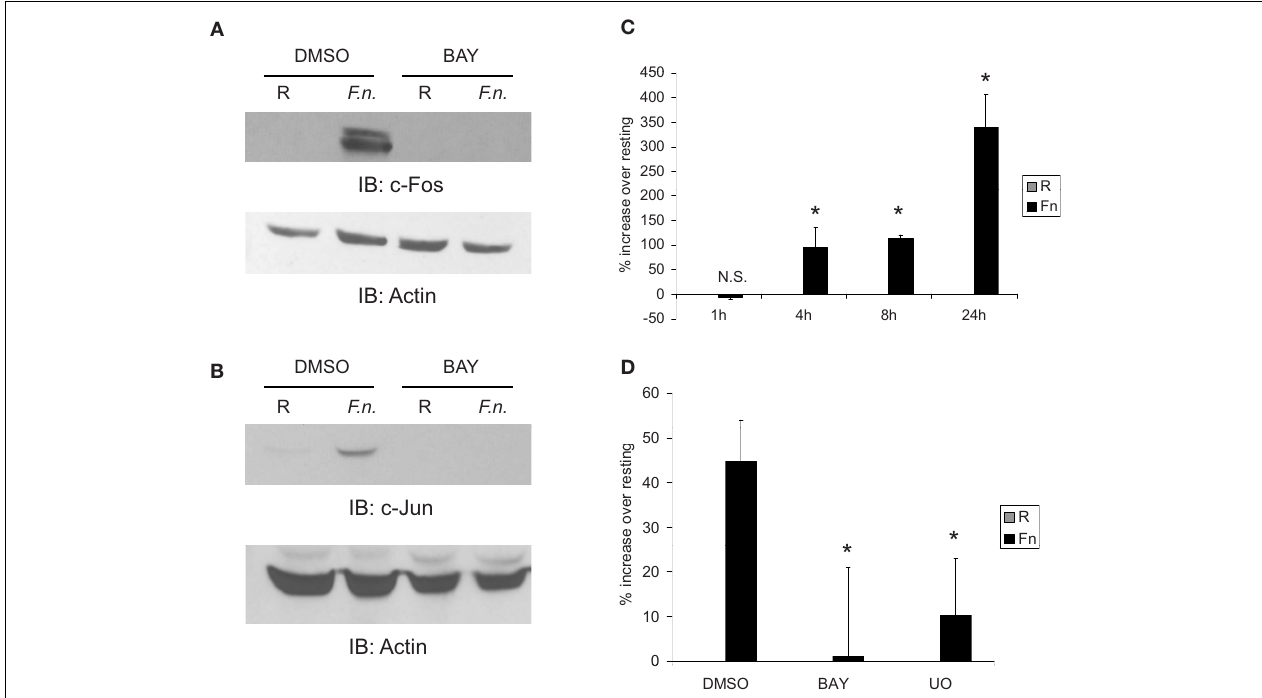
with F.n. at an MOI of 50 for 1, 4, 8, or 24h. Cells were lysed and luciferase activity was measured by a luminometer in triplicate. Data are represented as % increase over uninfected control. (D) RAW264.7 macrophages were transfected with the AP-1 reporter as in (C) . Fourteen hours post-transfection cells were pre-treated with DMSO vehicle control, BAY-11-7085, or U0126 then infected for 8h. Data are represented as % increase over uninfected samples.These data are representative of three independent experiments. *Designates a p value < 0.05.